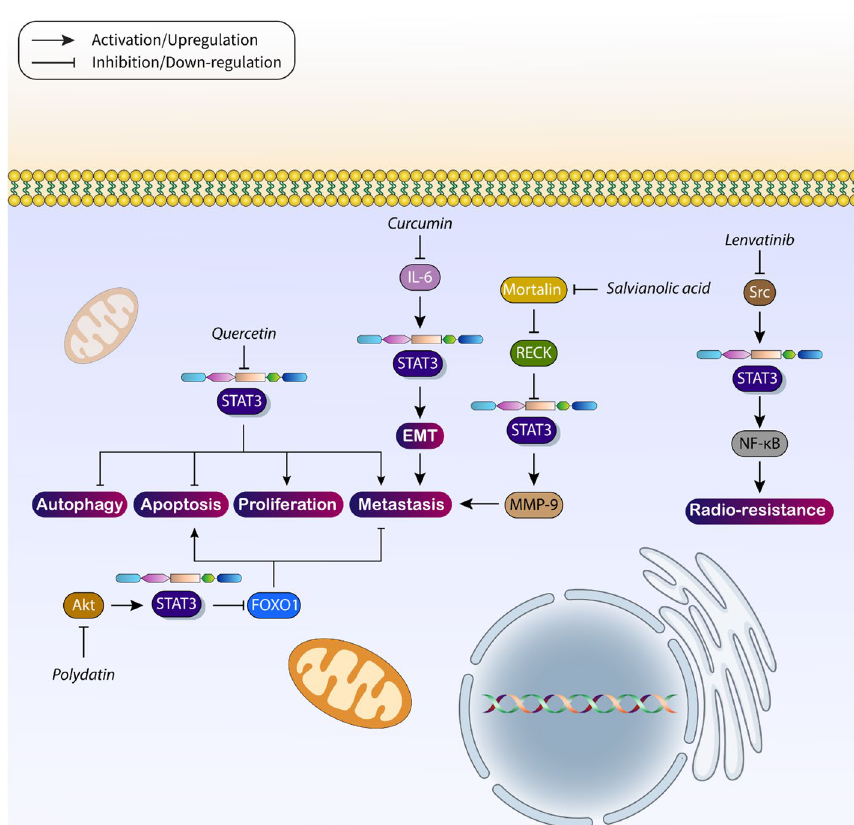
Fig. 6 Antitumor compounds target STAT3 signaling in